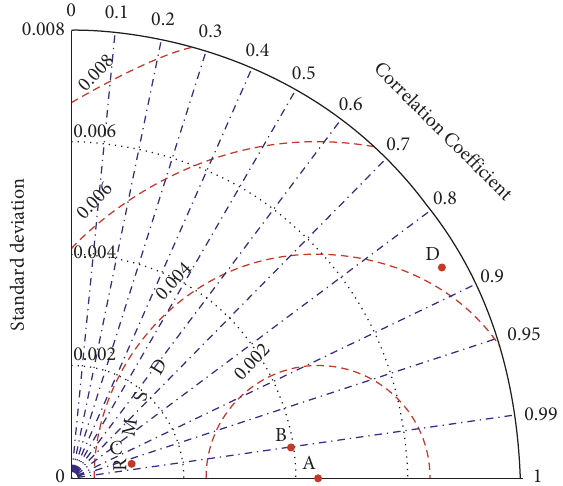
Figure 8: Taylor diagram of MPA-ANN, CPSOCGSA-ANN, and SMA-ANN predicted models.